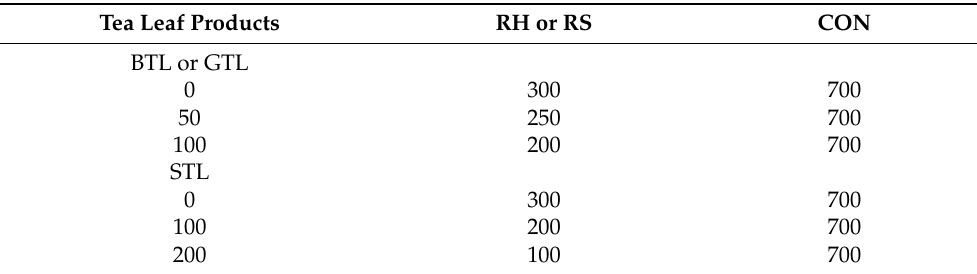
Table 1. Ingredient compositions (g/kg DM) of the RH- or RS-based experimental diets containing either original tea leaves (BTL, GTL) for the first experiment and their STL (SBTL, SGTL, CSBTL, CSGTL) for the second